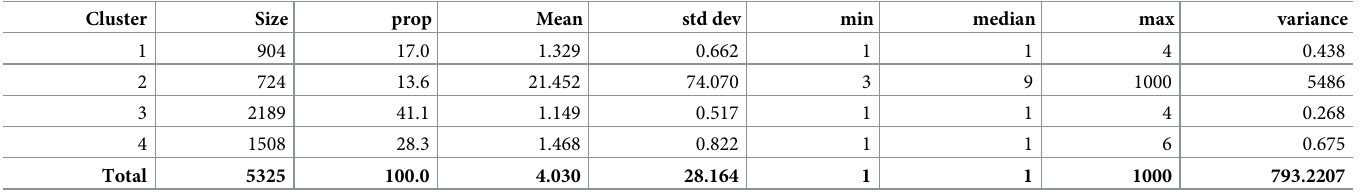
Table 4. Summary statistics of clustering using the response variable only (counts) for Barrow Island from 2009 to 2015.